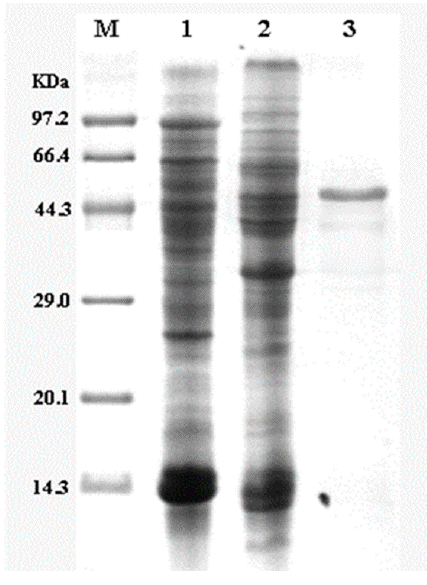
Figure 3. SDS-PAGE analysis of the expression of glutaminase in BSM4. Lane M: protein marker; lane l: cell extract of B. subtilis 168 (negative control); lane 2: cell extract of recombinant BSM4; and lane 3: purified glutaminase.